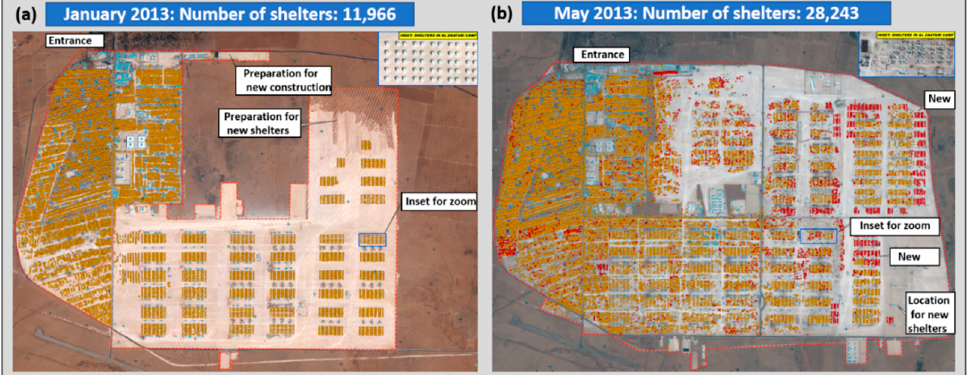
Figure 4. Satellite-detected shelters at the Al Zaatari refugee camp, Jordan ( a ) 3 January 2013 (WorldView-2 image), and ( b ) 4 May 2013 (WorldView-1 image) (Source: UNITAR/UNOSAT).